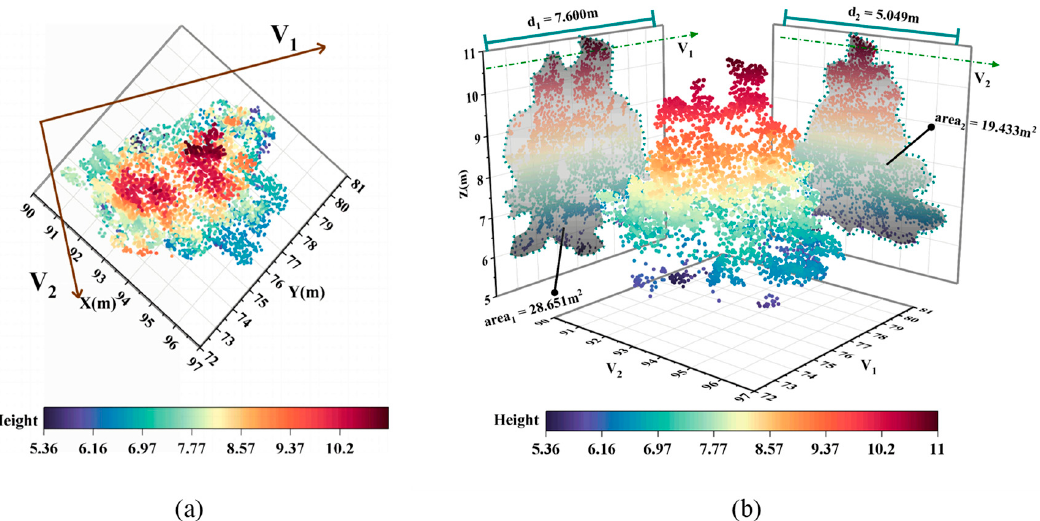
Figure 4. ( a ) PCA-based calculation of the principal canopy direction to obtain the direction con- taining the maximum information, V 1 , and the next V 2 ; ( b ) after the samples are projected in the principal direction, the polar differences of the projection point set transverse coordinates are d 1 , d 2 , and the internal area of the boundary of the projection point set is area 1 , area 2 , as shown in the gray shaded part of the diagram.